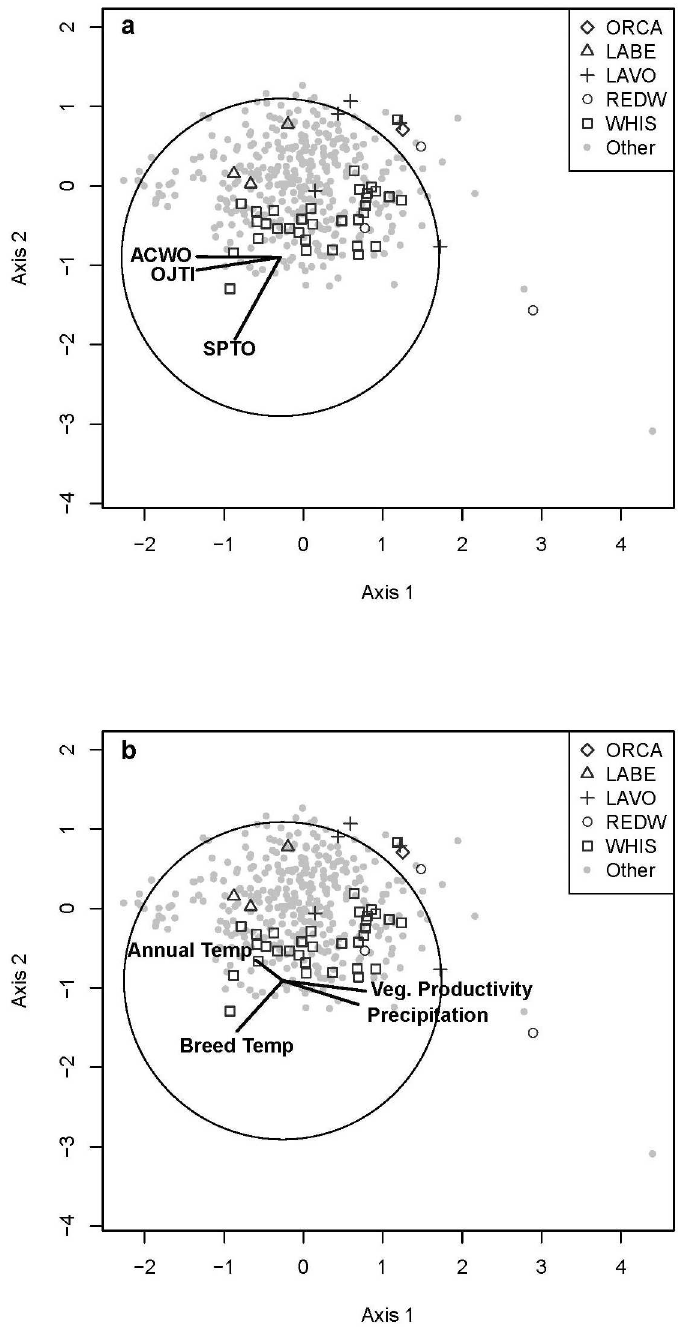
Fig 4. Bird Communities and Environmental Variables in Mixed Conifer-Hardwood Habitat. Relationship of individualbird sites (displayedby park unit) identifiedas mixed conifer-hardwood habitat (see text) using Non-metric Multidimensional Scaling. Biplots are direction and relative strength of Pearson correlationcoefficients (the circle indicatesa correlationof 1) between bird sites and (A) underlying bird species with a rho of > 0.5 and (B) environmental variablesthat maximized the overallcorrelationthrough BIOENV (Table 4). See S1 Table for bird codes and S2 Table for definitions and abbreviations of environmental